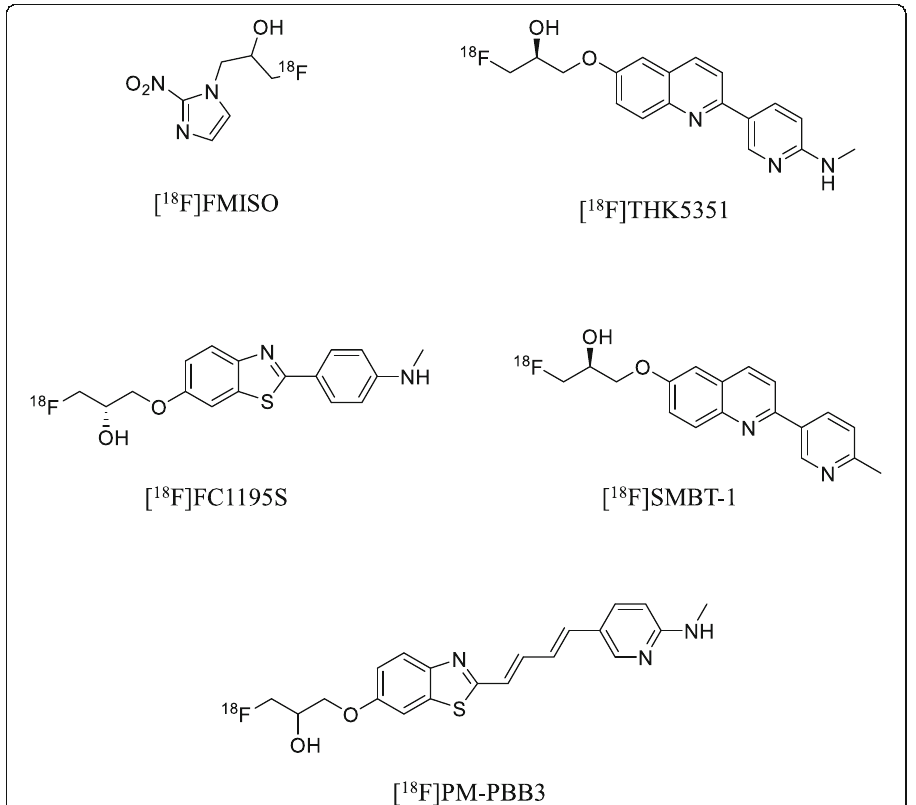
Fig. 1 Chemical structures of PET tracers containing (3-[ 18 F]fluoro-2-hydroxy)propyl ([ 18 F]FHP) moiety used in clinical applications. [ 18 F]FMISO (Bruehlmeier et al. 2004; Eschmann et al. 2005); [ 18 F]THK-5351